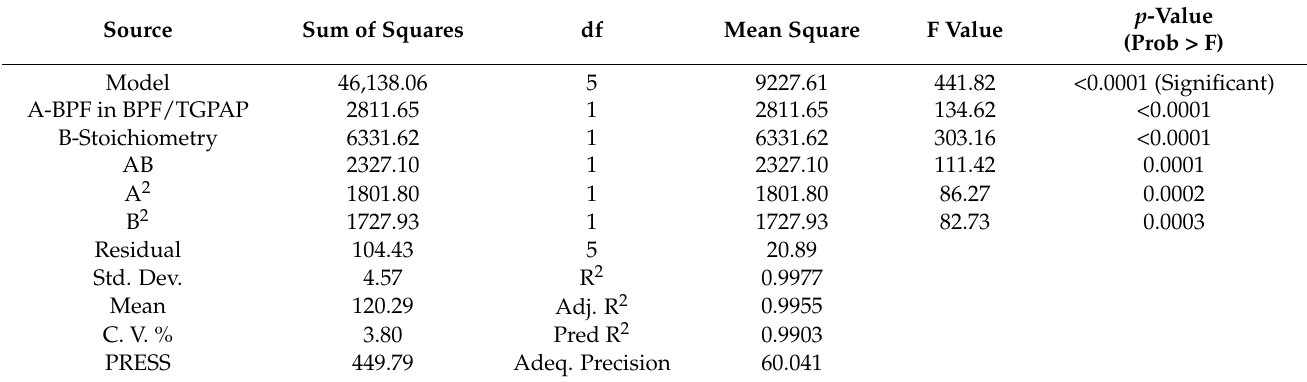
Table 4. ANOVA table for the surface response quadratic model (response: PW).